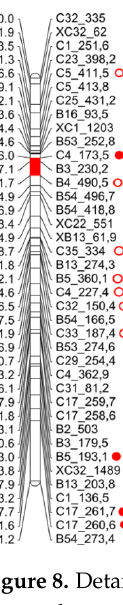
Interestingly, both F 1 populations showed markers associated with the trait on LG3 and also on LG10, but the latter has an arbitrary number in both parental maps as it was not possible to identify female and male homologous. Then, focusing on LG3, both maternal LG3 and paternal LG3 were combined using the “ Combine Groups for Map Integration ” function (JoinMap 4.0) to characterize the relative order between the two groups of markers. The integration generated a new LG3 of 131.2 cM with a total of 39 markers. Most of the markers associated with apospory expressivity, identified from each population, clustered in different regions of the LG3, however, one marker from the F 1-C , B4_490.5 (R 2 = 0.13; p = 0.03) and another from the F 1-Z , C4_173.5 (R 2 = 0.12; p = 0.02) enclosed a region of 5.7 cM (Figure 8).